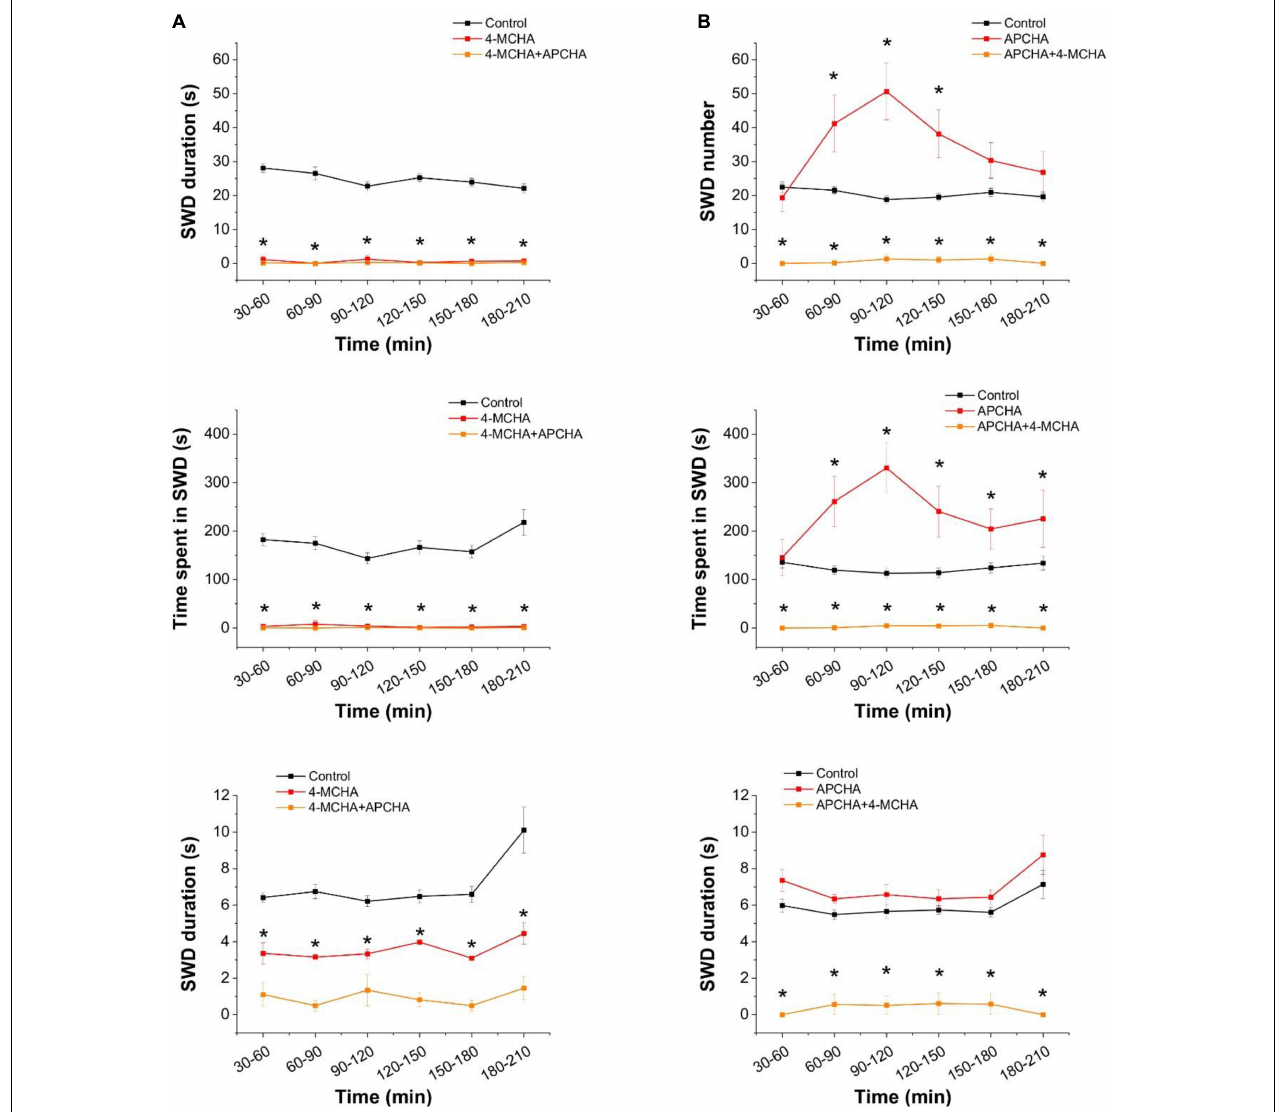
FIGURE 3 | Inhibition of spermidine synthesis blocks, inhibition of spermine synthesis enhances the appearance of spike-wave discharges in the in vivo WAG/Rij rat model of absence epilepsy. (A) Effect of the spermidine synthase inhibitor 4-MCHA (25 mg/kg) on SWD number (top), total SWD time (center), and average SWD duration (bottom). (B) Effect of the spermine synthase inhibitor APCHA (25 mg/kg) on SWD number (top), total SWD time (center), and average SWD duration (bottom) ( n = 8 animals in each group). Asterisks denote significant ( p < 0.05) difference from the